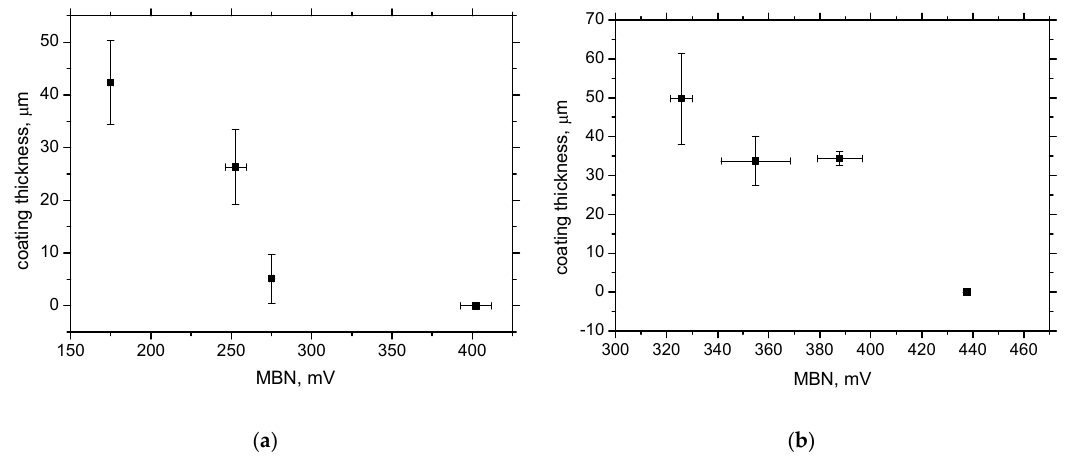
Table 3. Thickness of the galvanized layer in micrometers on the surface wire